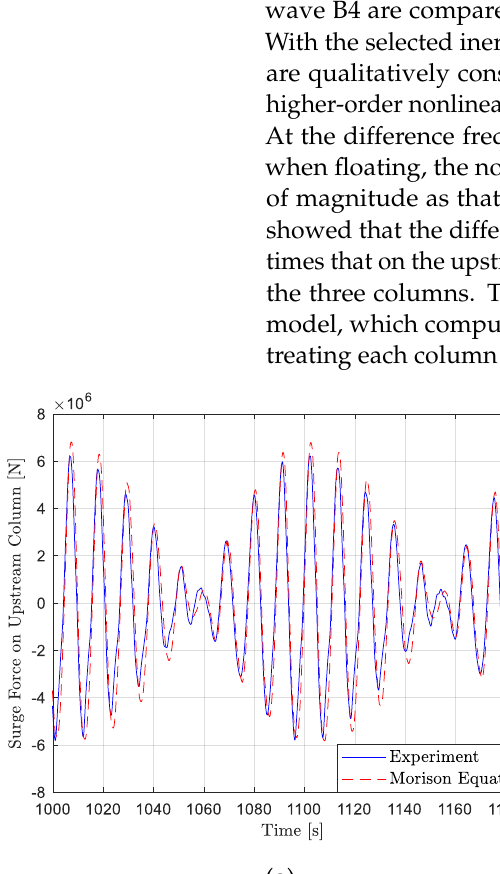
16 of 25 Figure 14. Power spectral densities of full-scale ( a ) surge force and ( b ) pitch moment on the upstream column of Config- uration P in irregular waves J1 and J2. Finally, a qualitative comparison between the experimental results and the predic- tions from the Morison equation was performed to check the validity of the experimental measurements. For this simple validation, only the surge force was considered because the heave force and pitch moment are strongly influenced by the vertical drag force on the heave plates, which needs to be modeled with care. This is beyond the scope of this article and is discussed in detail in [34]. Using OpenFAST, which adopts a strip-theory- type implementation of the Morison equation [35], the surge (transverse) force on each upper column and heave plate was computed with an inertia coefficient of 𝐶 𝑀 = 2 , which is the theoretical value for a fixed circular cylinder in an ideal infinite oscillatory flow. Following the recommendation from [36] for a similar geometry, a drag coefficient of 𝐶 𝐷 = 0.4 was used for the upper columns and 𝐶 𝐷 = 1.6 was chosen for the heave plates. No further tuning of the hydrodynamic coefficients was performed for the present pre- liminary comparison. The wave-induced surge forces on the upstream and starboard columns of Configu- ration P (three columns with HP1 at zero pitch angle) and bichromatic wave B4 are com- pared in Figure 15. Both time series and amplitude spectra are shown. With the selected inertia and drag coefficients, the predictions from the Morison equation are qualitatively